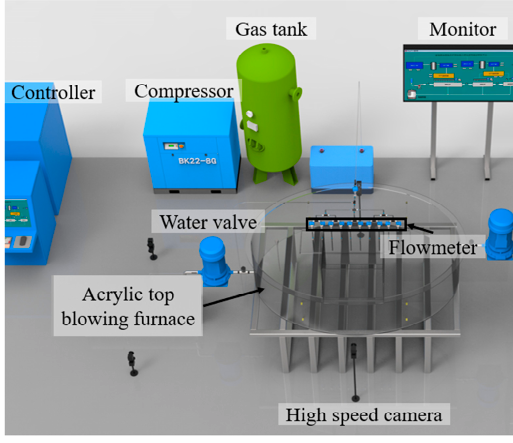
Figure 4. Experimental apparatus.